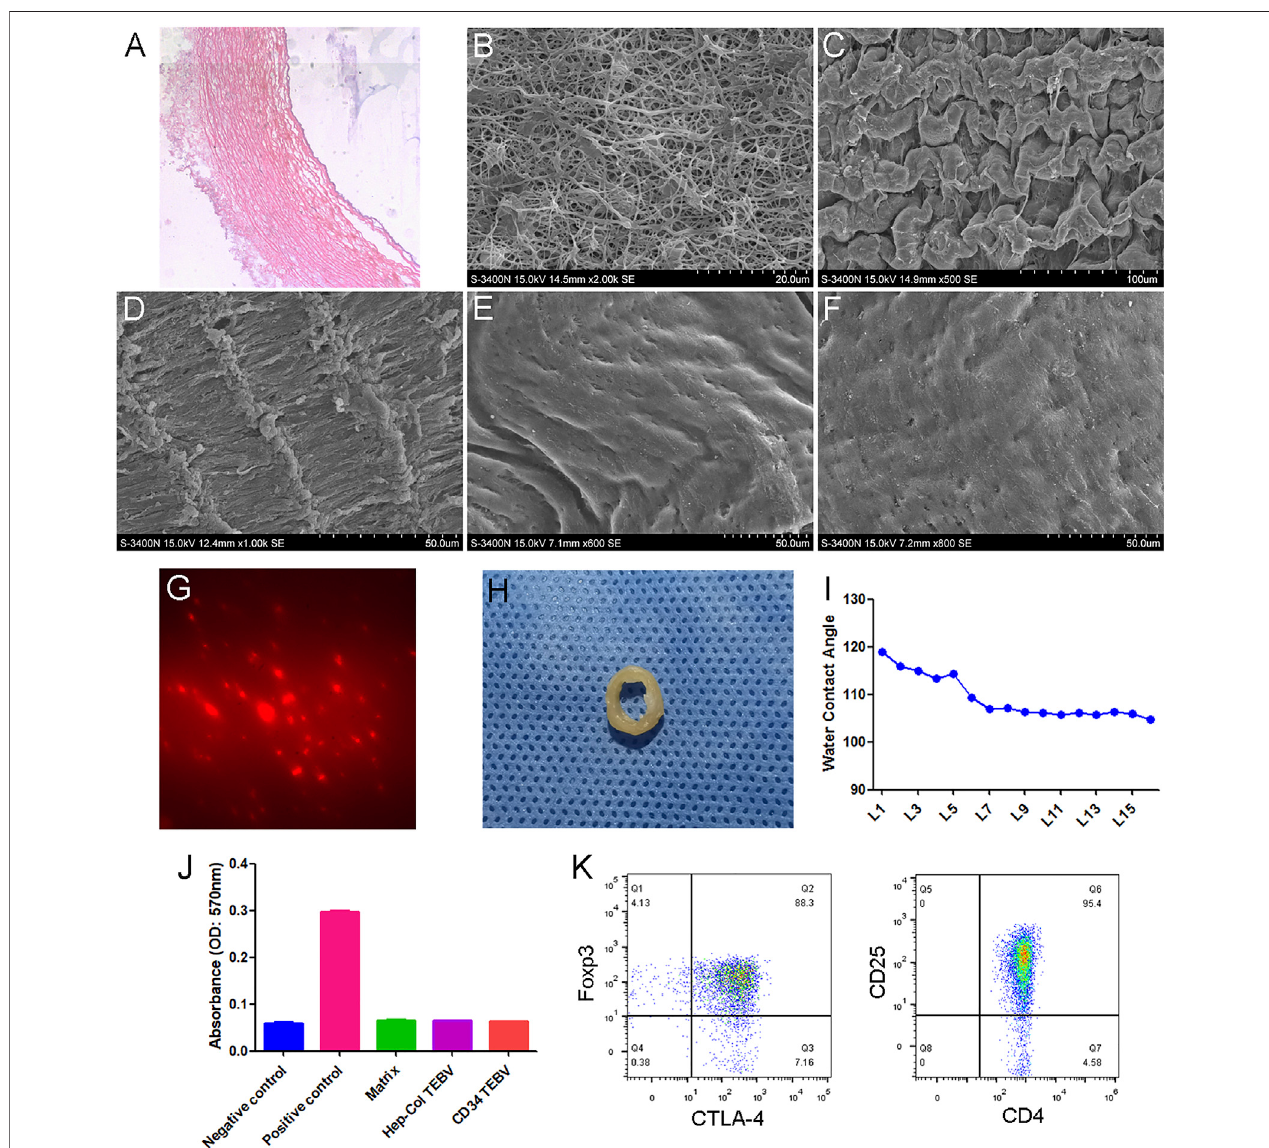
FIGURE 1 | Characteristics of anti-CD34 antibody modi fi ed TEBV. (A) H&E staining of TEBV acellular scaffold. (B) Transmission electron microscopy images. Scanning electron microscope showing the surface of TEBV scaffold before coating (C) and after coating 2 layers (D) , 5 layers (E), and 10 layers (F) . (G) Red fl uorescence(CD34-PE)couldbeobservedonthesurfaceofTEBVafter2 hofwashingwithnormalsaline. (H) Thegeneralpictureofanti-CD34antibodymodi fi edTEBV. (I) WaterContactAngletestresultsshowedthatthecontactangledecreasedwiththeincreaseofcoatinglayers.Thecontactangledidnotchangesigni fi cantlyafter 7 layers of coating. (J) In vitro hemolysis experiments showed that coating of collagen, heparin and CD34 antibody had no signi fi cant effect on the hemolysis of the acellular vascular matrix. (K) Flow cytometry results showed that more than 90% of the expanded cells expressed both CD4 and CD25. Foxp3 and CTLA-4 were also highly